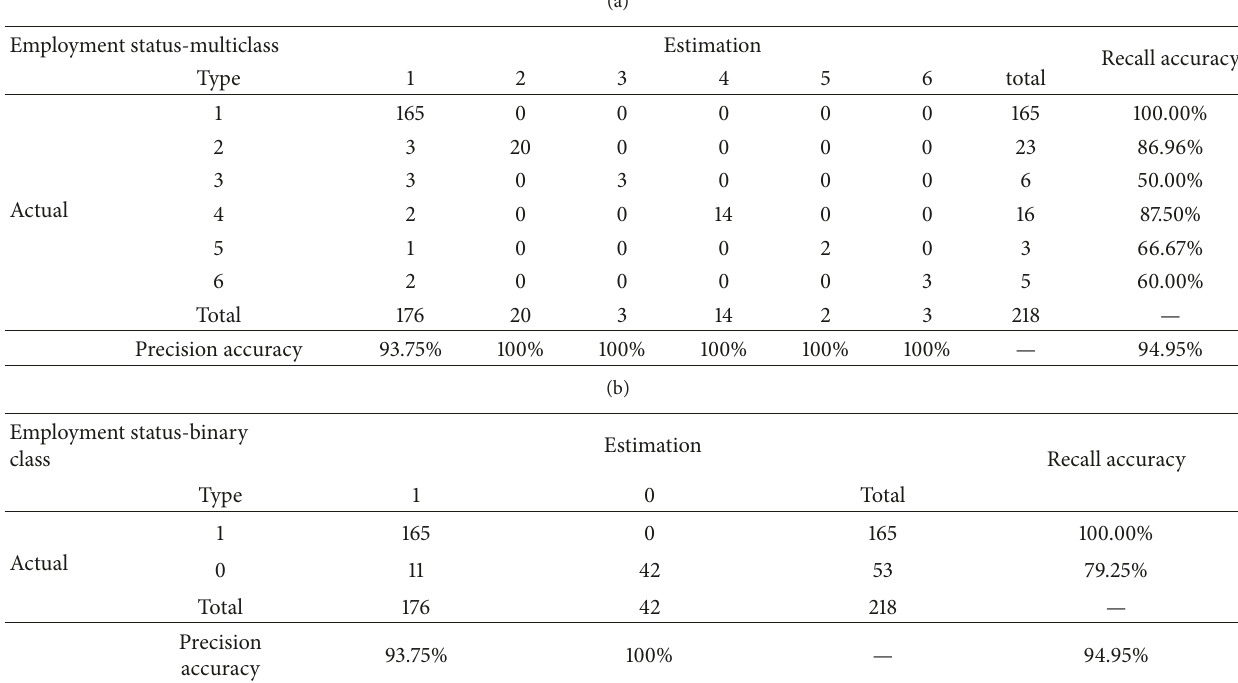
Table 3: Multiclass and binary class employment status SVM prediction